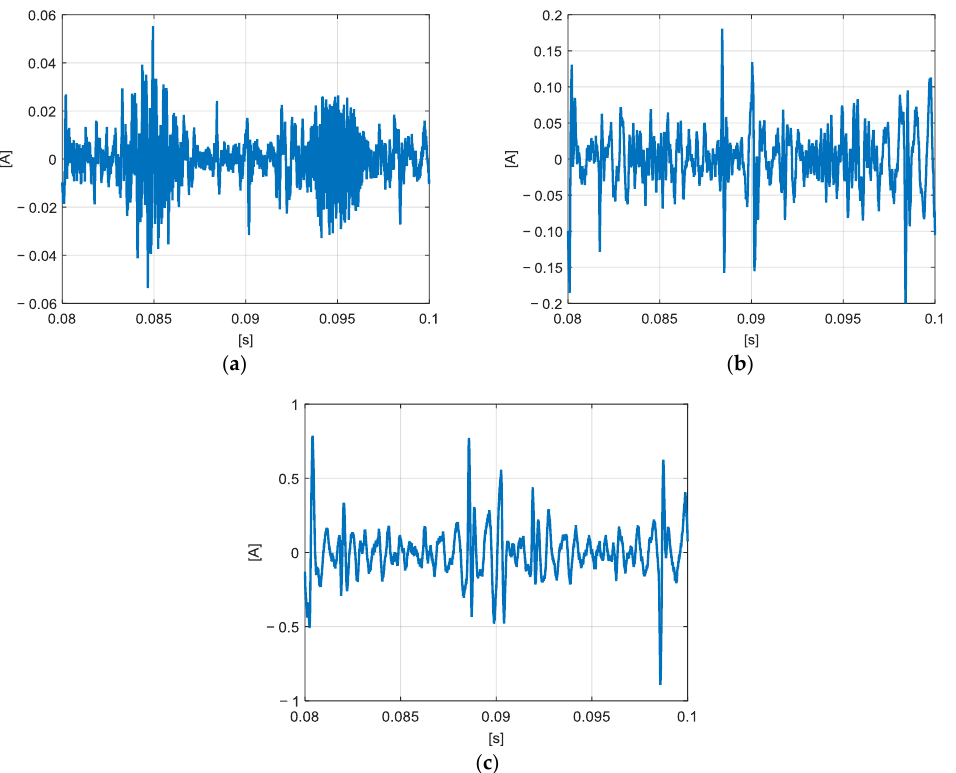
Figure 47. Case study 4: time trends of the high-frequency waveforms for ( a ) one lamp, ( b ) ten lamps, and ( c ) forty-eight lamps.